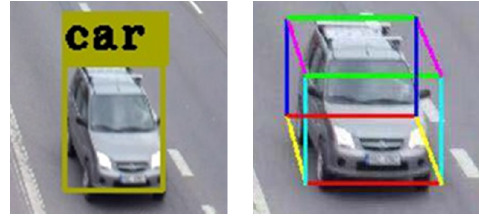
Figure 7. Schematic diagram of 2D ( left )/3D ( right ) vehicle detection.